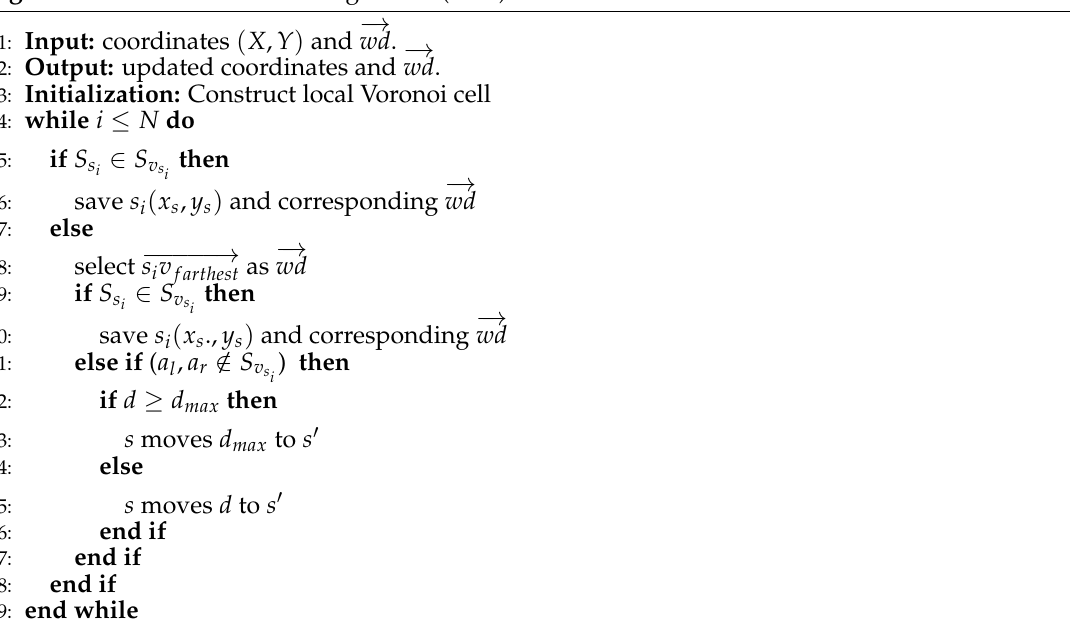
Algorithm 2 Move Inside Cell Algorithm